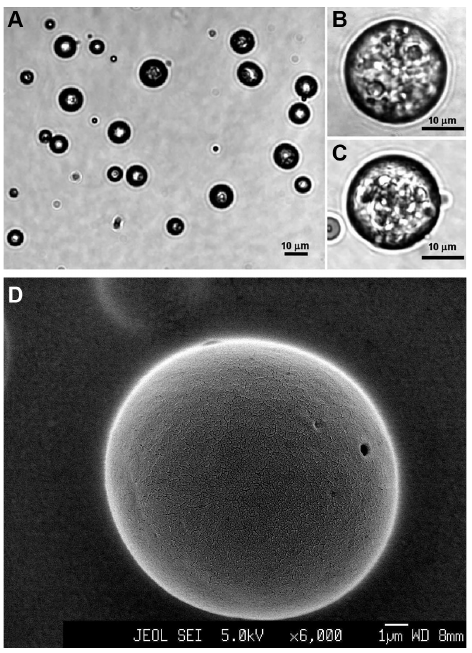
FIGURE 2 - Morphological characterization of insulin-loaded PCL microparticles. Optical microscopy ( A, B and C ). Scanning Electron Microscopy ( D ). Details in the Material and Methods section.